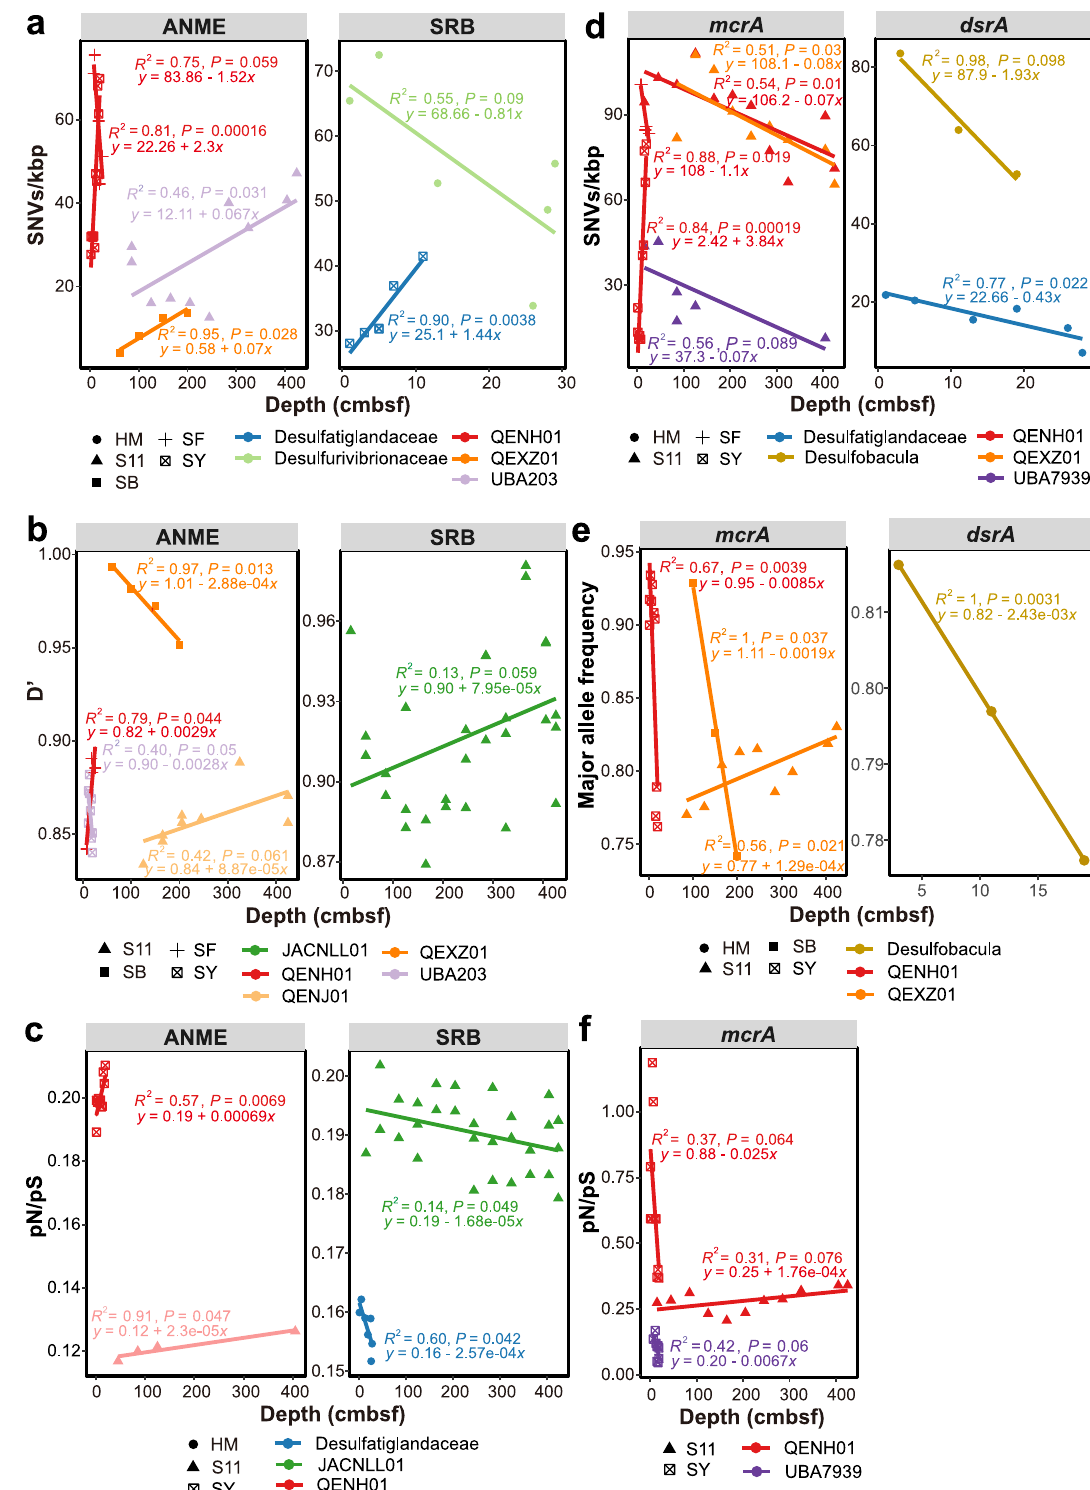
Fig.6|Relationshipsbetweenevolutionarymetricsanddepths(cmbsf)ofcold seepsedimentsamples.a – c ComparisonofSNVs/kbp,pN/pSratio,andD ′ against sediment depths at the whole-genome level. d – f Comparison of SNVs/kbp, pN/pS ratio, and major allele frequency against sediment depths at the gene level. Each dot represents one species-level microbial population. Linear regressions and R 2